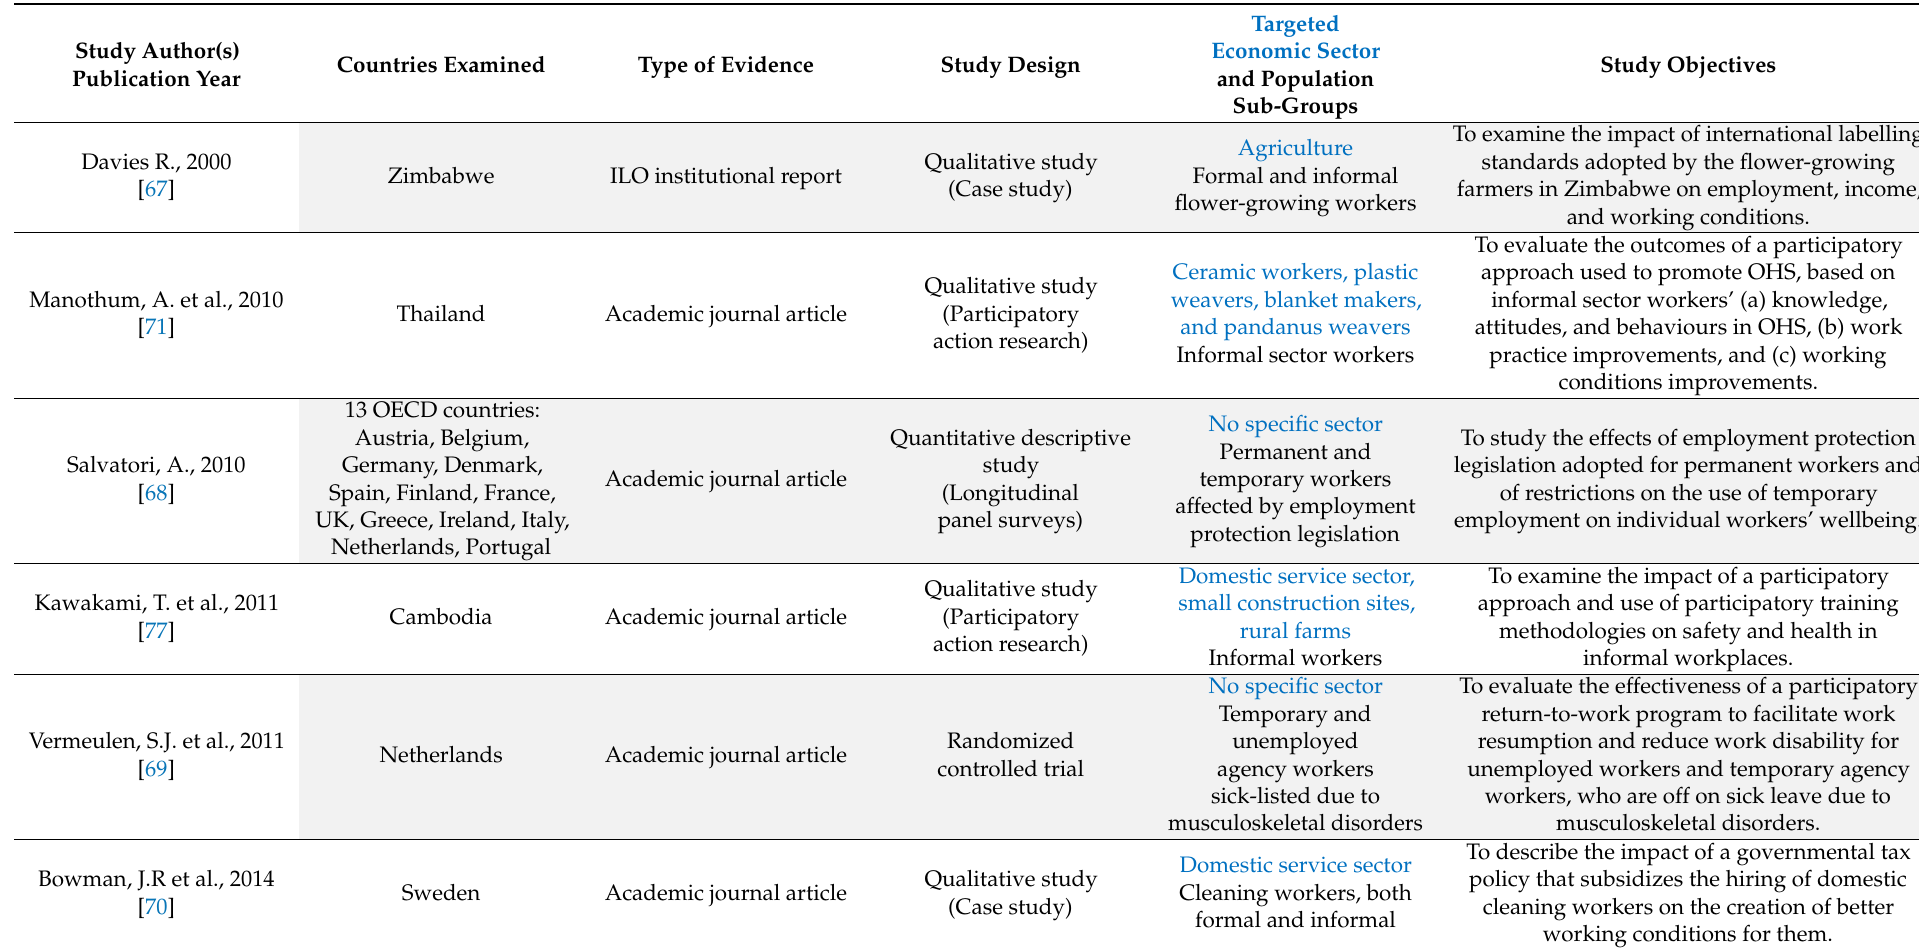
Table 2. Countries examined, type of evidence, study design, targeted economic sector, population sub-groups, and study